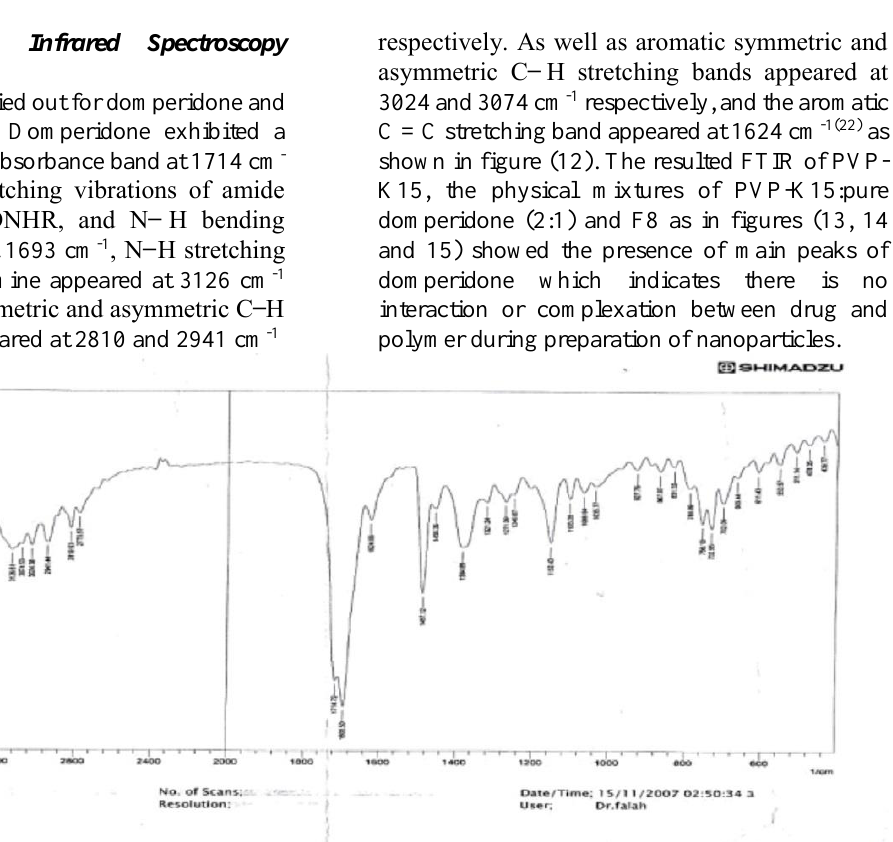
Figure 12. FTIR spectrum of pure